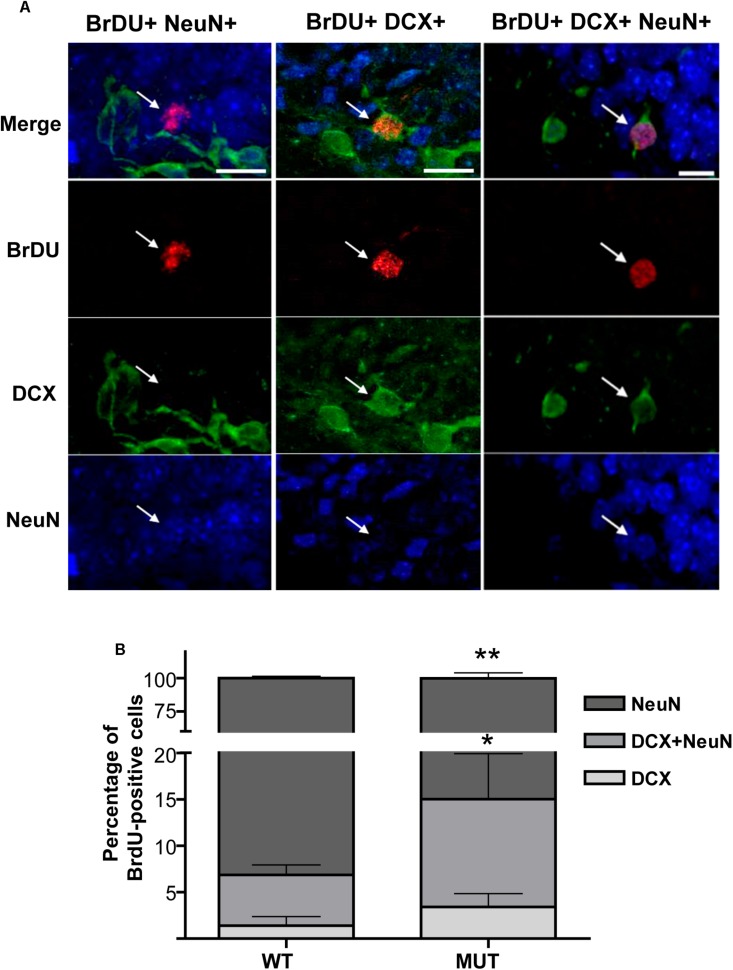
Defective maturation is recapitulated in MeCP2 mutant adult-born granule neurons. (A) Triple IHC labeling of BrdU-positive cells and neuronal markers NeuN and DCX. Examples of BrDU-positive neurons in intermediate state of maturation that co-express both NeuN and DCX (right panel). Example of a mature neuron that only expresses NeuN (left panel) and an immature neuron that only expresses DCX (middle panel). The vertical panels are unique optical planes showing the three fluorescence channels separately and their overlapping in the upper panel. Scale bar: 15 μm. (B) Percentages of BrdU-positive cells in different stages of maturation in WT and MUT mice exposed to KA. 5 weeks after seizures, WT mice showed a high percentage of mature new granule cells (90%), while MUT mice presented significantly less mature cells and more immature cells. Each bar represents the mean ± standard error (SEM) of BrdU-positive cells co-localizing with the corresponding markers, normalized to the total number of BrdU-positive cells in each mouse. Each bar is subdivided to indicate the mean percentage of BrdU-positive cells at different states of maturation. n = 4–5 mice per experimental group. Data analysis: two-way ANOVA followed by Sidak’s test, *p < 0.05; ∗∗p < 0.01.